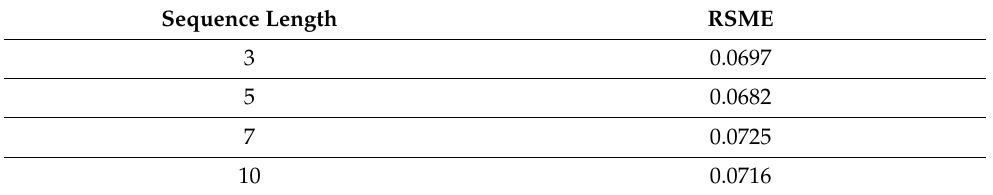
Table 17. Root mean squared error (RMSE) values based on sequence